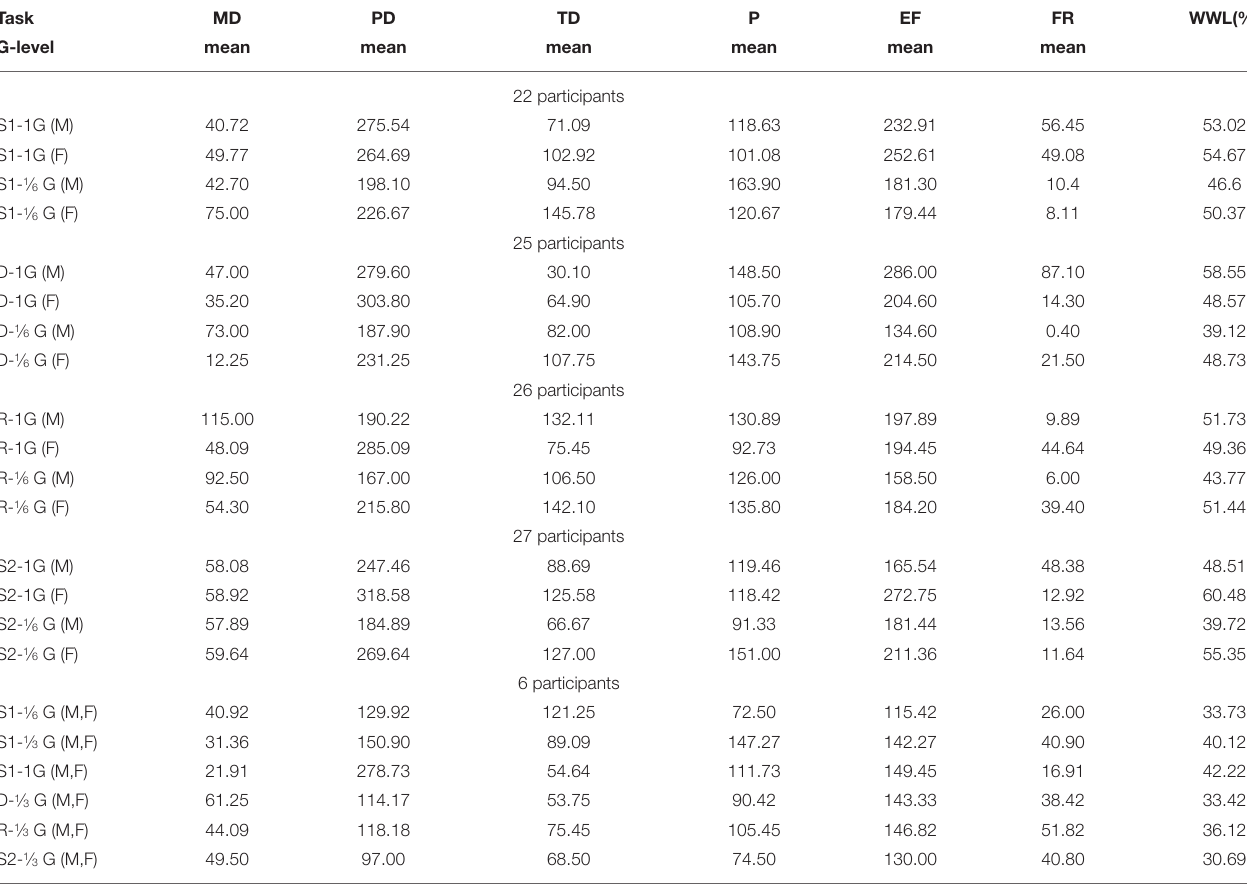
TABLE 4 | Summary of the calculated NASA-TLX parameters for the tasks with 3 kg load. Task